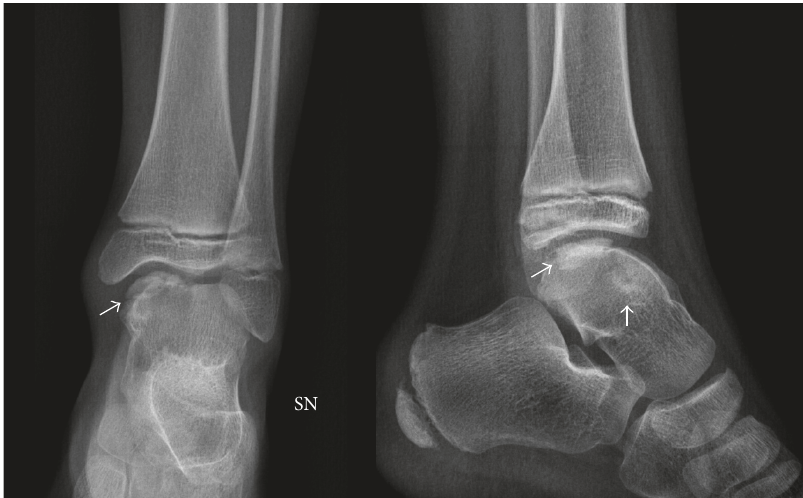
Figure 1: The X-rays show a bony-like protuberance localized at the anteromedial and posteromedial aspect of the talus (arrows).